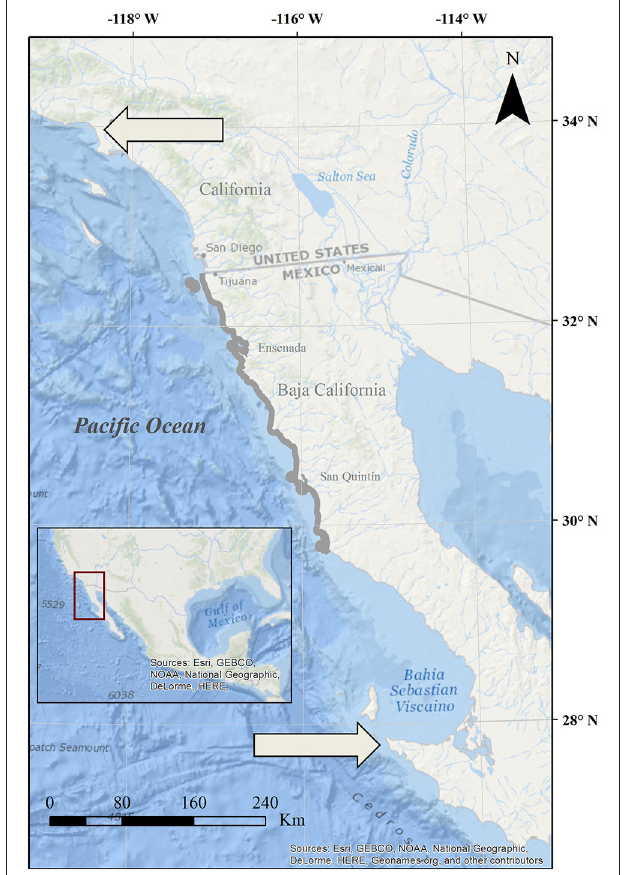
FIGURE 1 | Location of the Marine Priority Region for Conservation 1 (gray contour) in Baja California, Mexico. The arrows indicate the geographic limits of the Ensenadian eco-region from Santa Monica Bay, USA, to Punta Eugenia, Mexico.